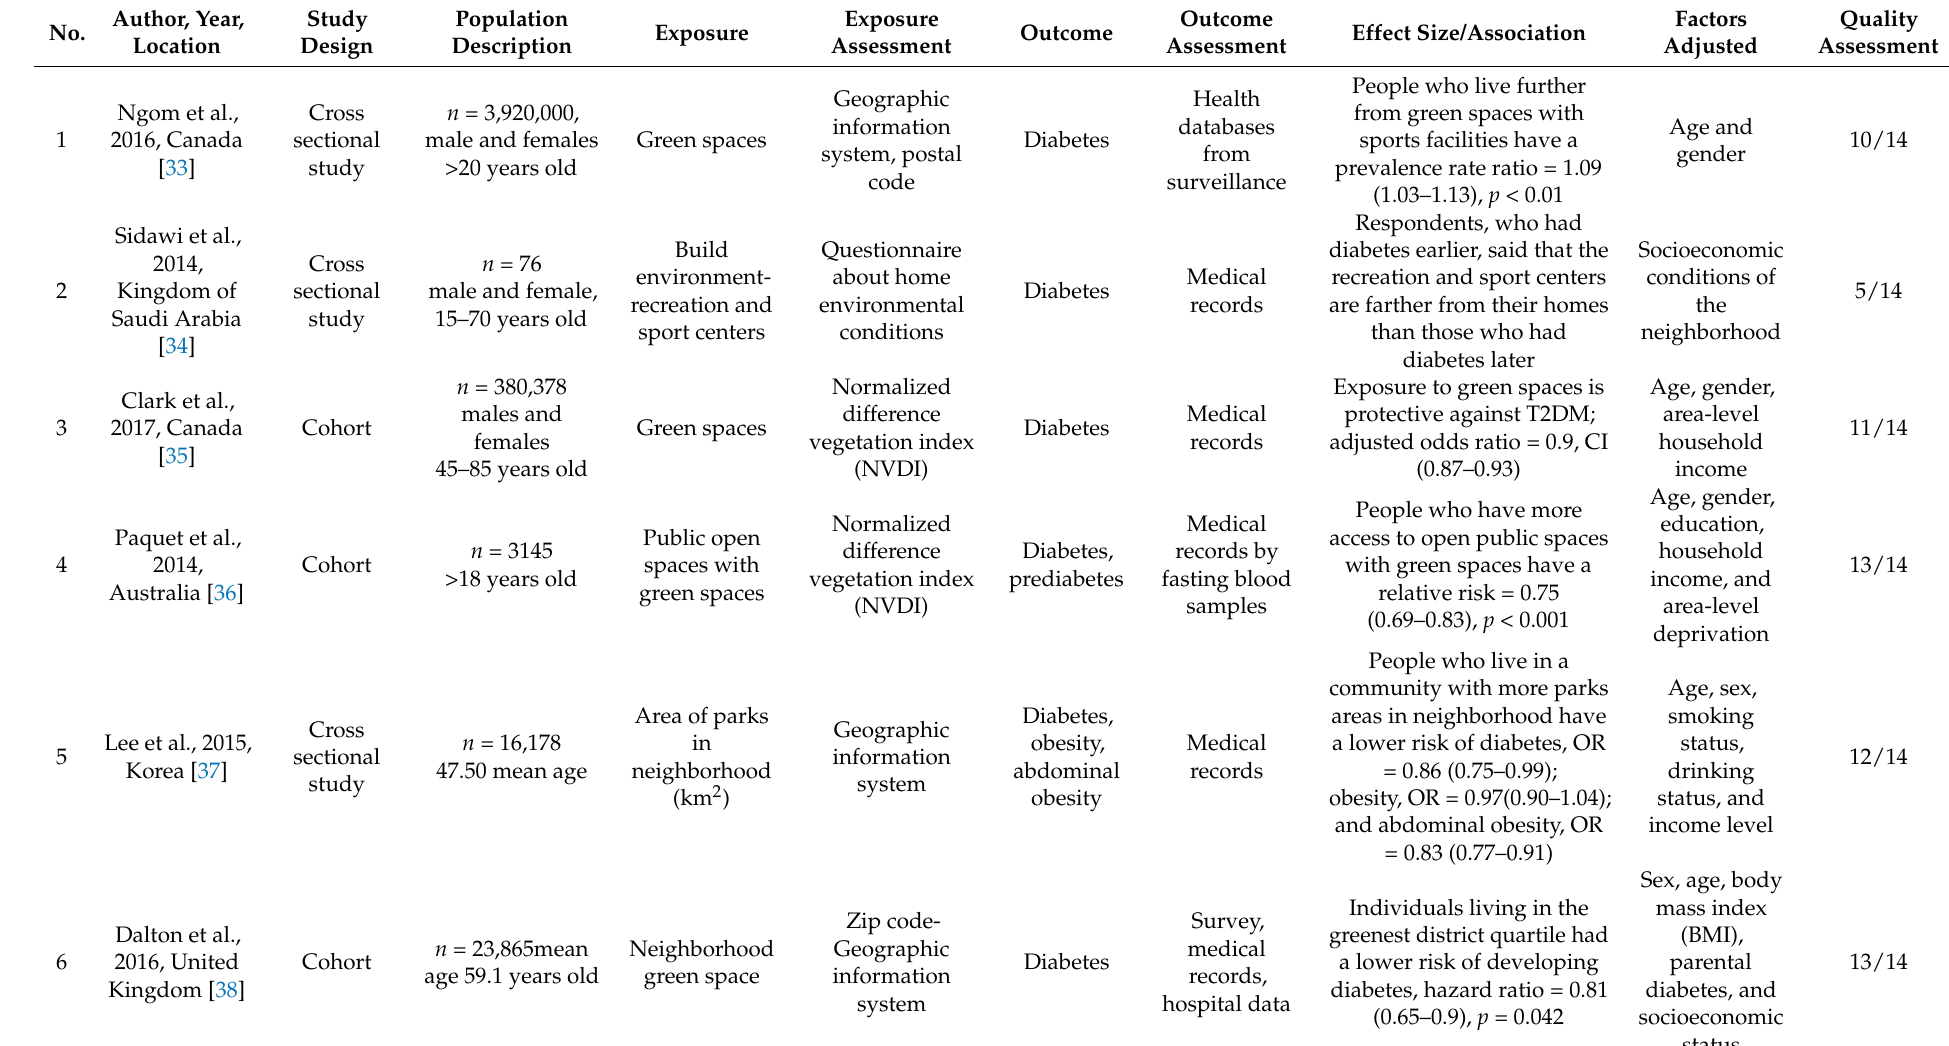
Table 1. Characteristics of included studies. Principal outcome: type 2 diabetes mellitus